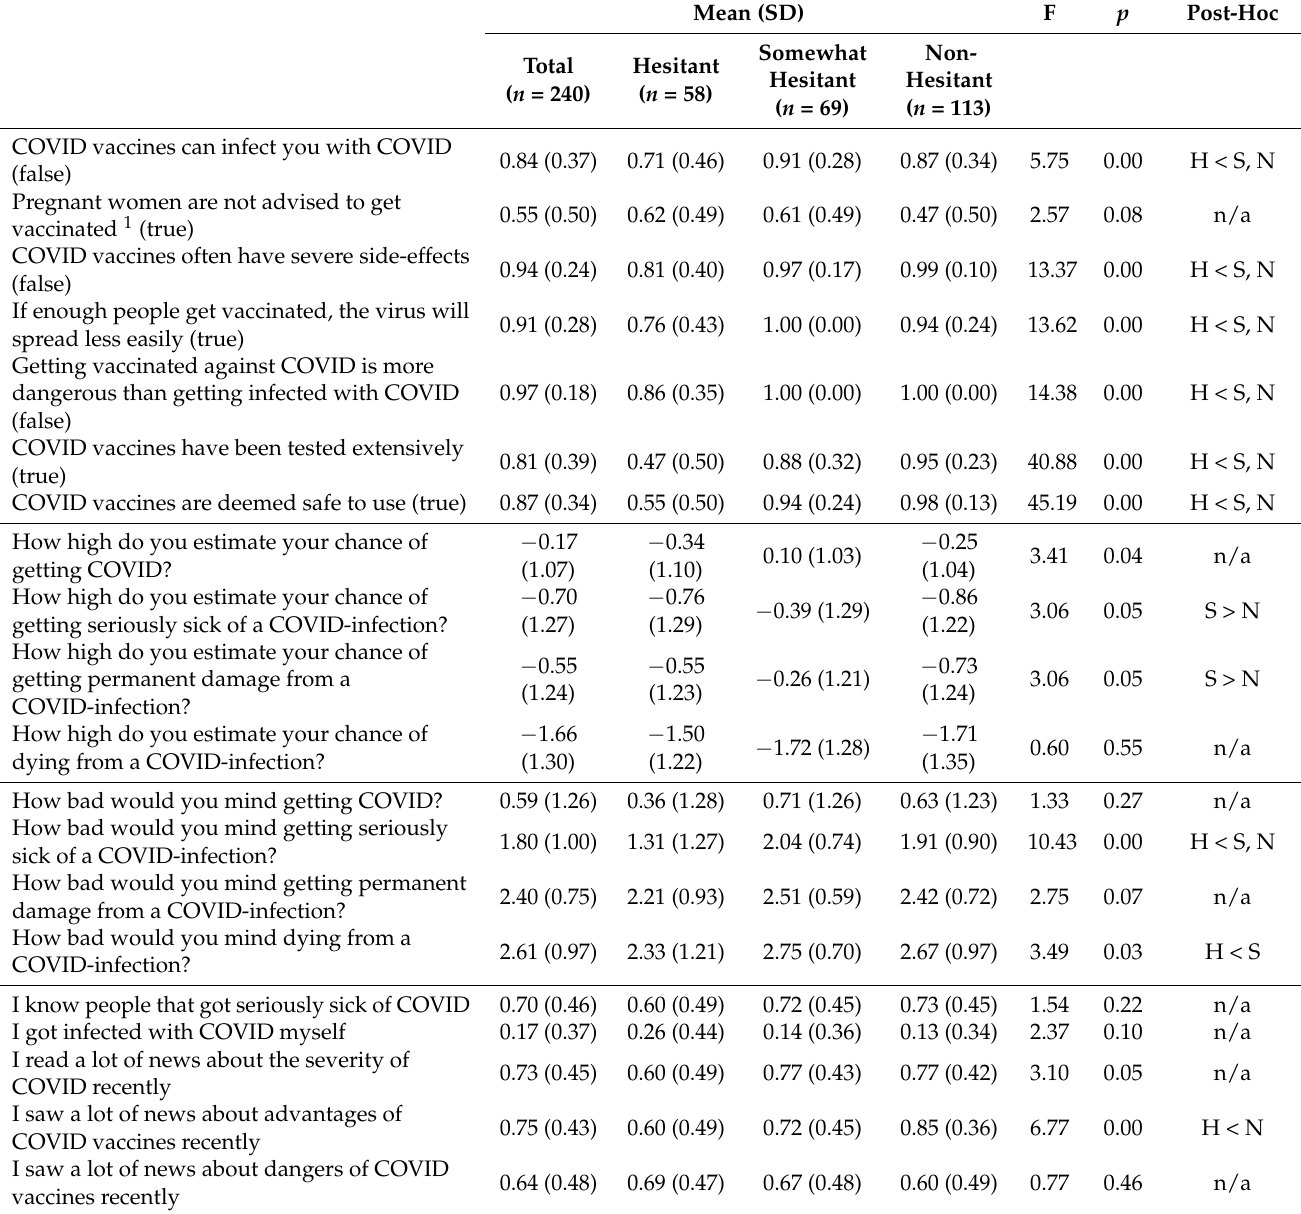
Table 3. Between-Group Variance Analyses for Awareness Factors. Mean (SD)